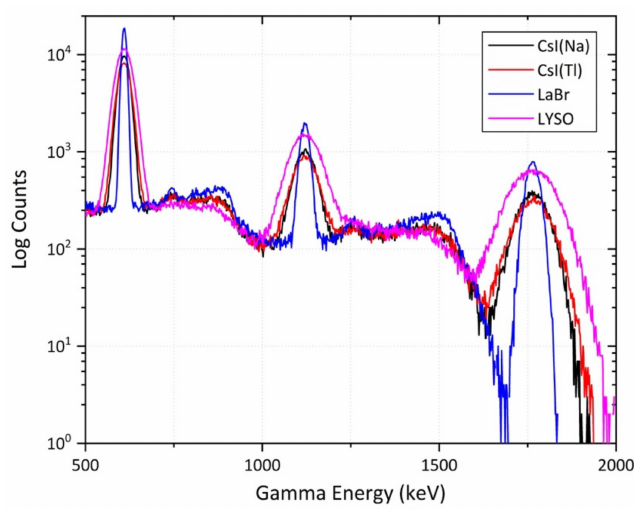
Figure 6. Comparison of the gamma-ray spectra obtained from various detector materials of identical volume when exposed to a 238 U point